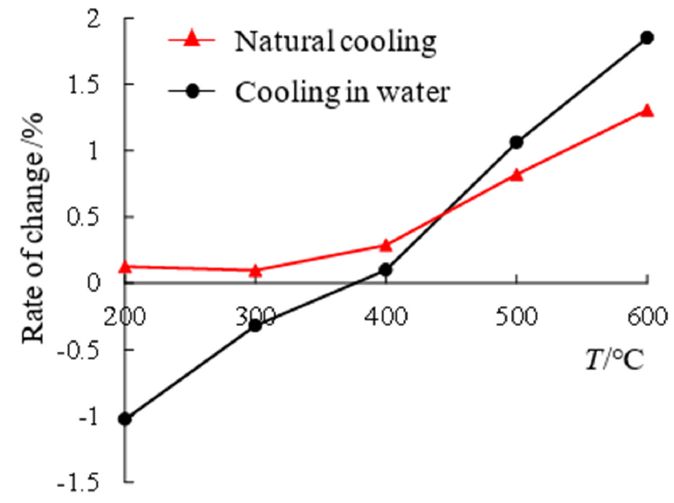
Figure 6. Density change under different cooling methods.